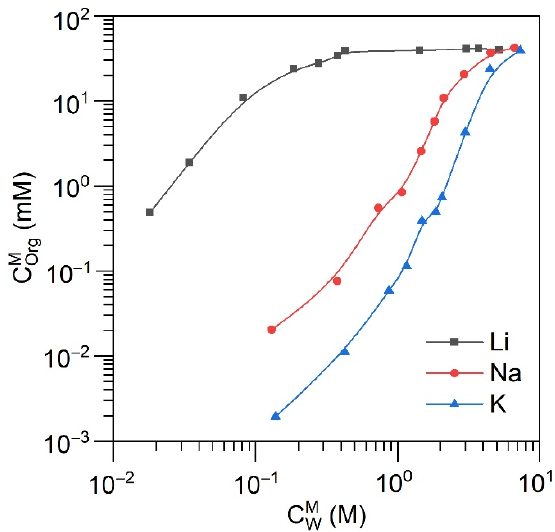
Figure 7. Extraction isotherms. The organic phase consists of 0.05 M salicylate and 0.05 M TOPO in heptane at 25 °C. O/A = 1:1.